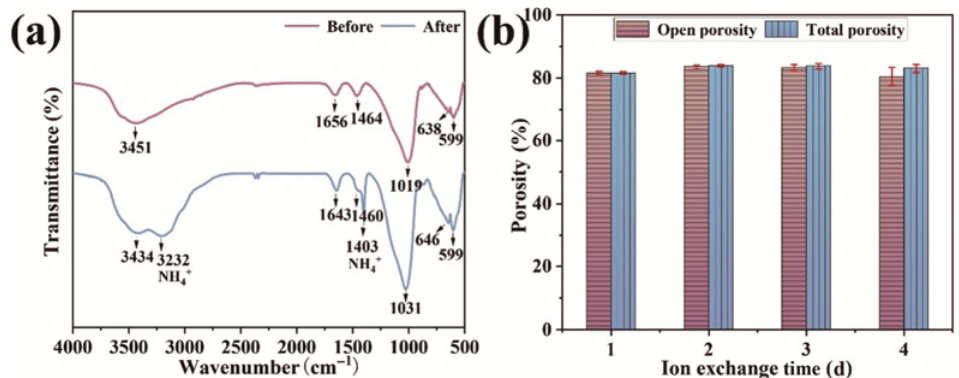
Fig. 6 (a) FTIR spectra of porous geopolymer sample before and after ion exchange and (b) open porosity and total porosity vs. ion-exchange